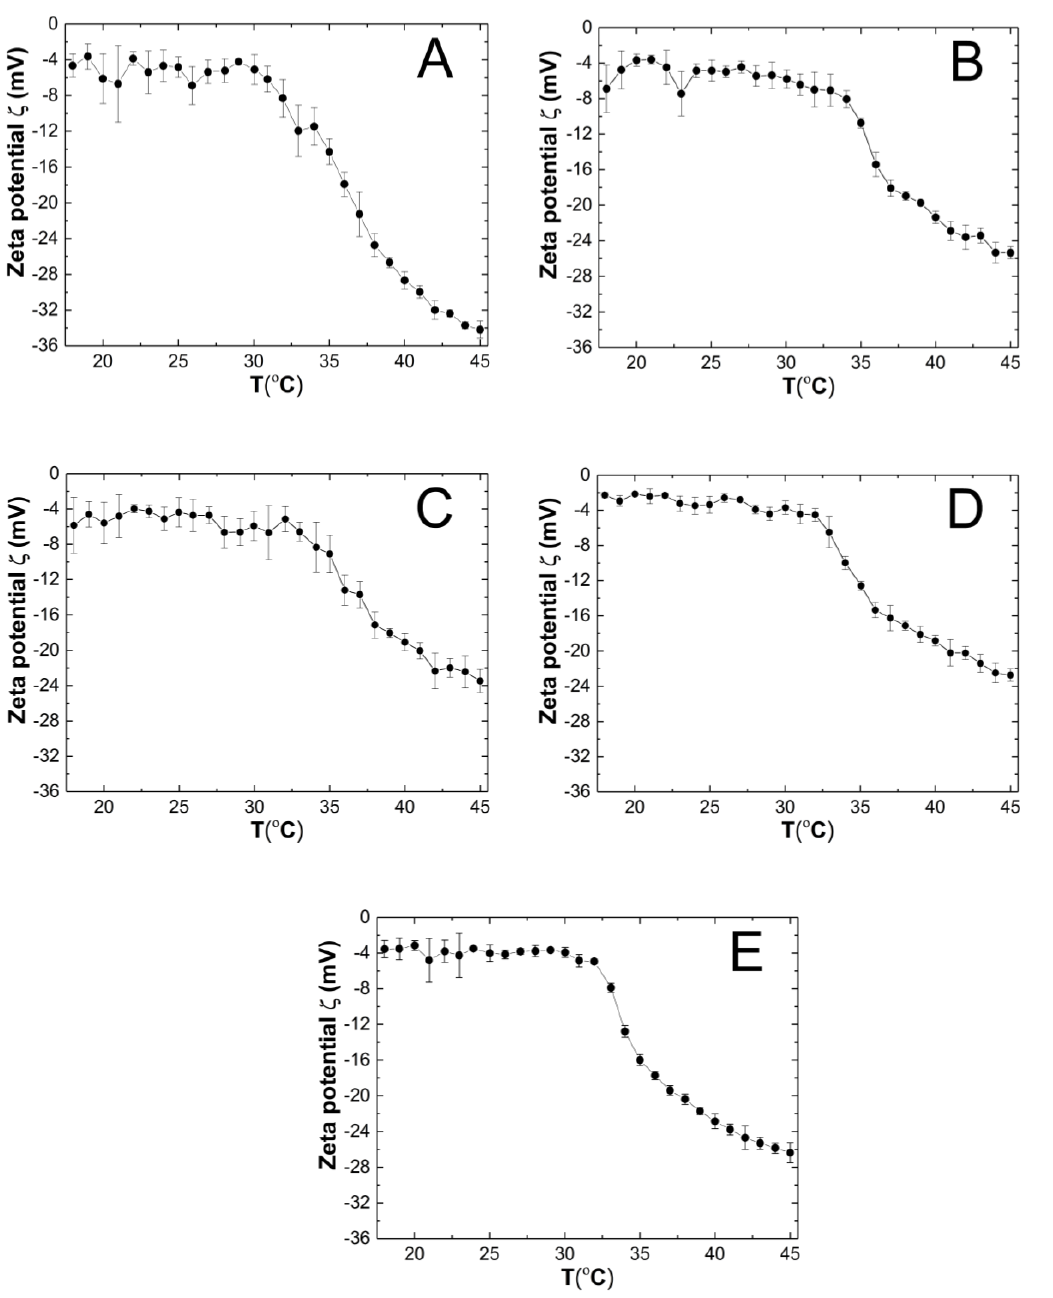
Figure 10. The influence of temperature on zeta potential (ZP) of the P1 ( A ), P2 ( B ), P3 ( C ), P4 ( D ), and P5 ( E ) samples as determined by electrophoretic mobility.